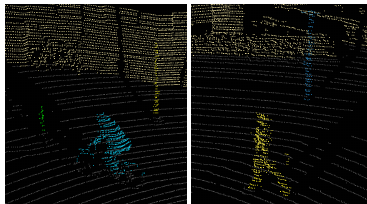
Figure 5. Example of point cloud segmentation using our model on various